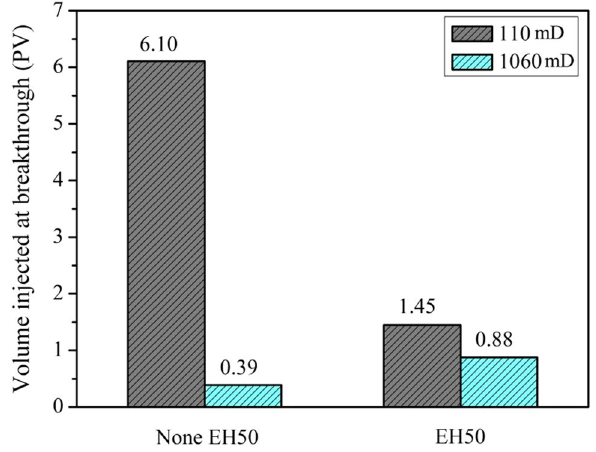
Fig. 5 Diversion effect experiment with and without EH50 (break- through PV) Table 3 Diversion experiments with diversion acid on parallel core